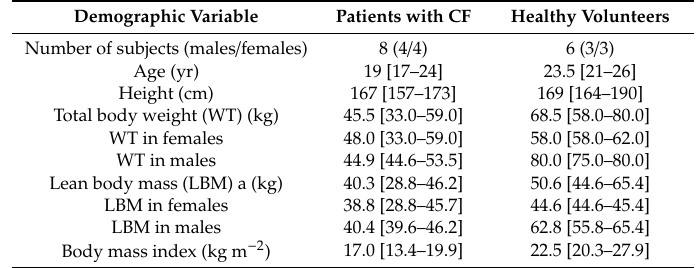
Table 1. Demographicdataofpatientswithcysticfibrosis(CF)andhealthyvolunteers(dataaremedian[range]).